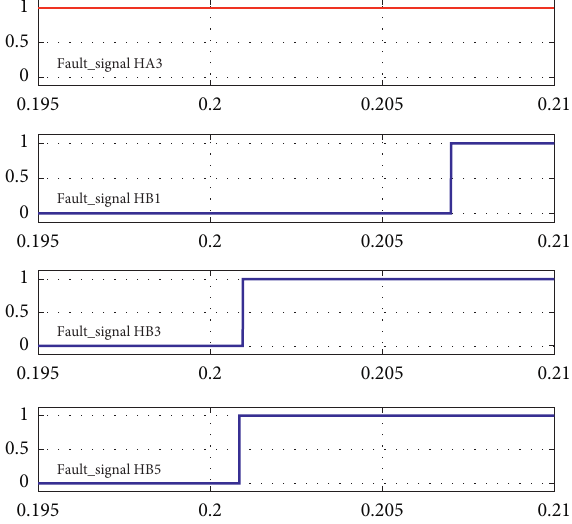
Figure 11: Fault signal of cells HA3, HB1, HB3, and